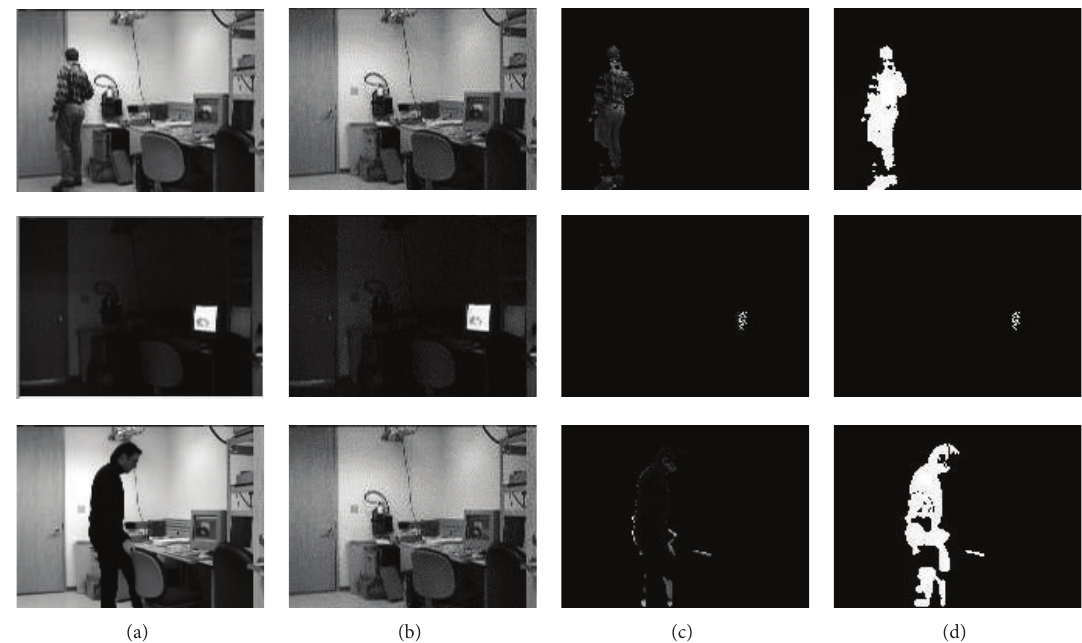
Figure 2: Results on a video sequence of 750 frames with sudden illumination changes. (a) Original frames, (b) background, (c) background subtracted images, and (d) foreground